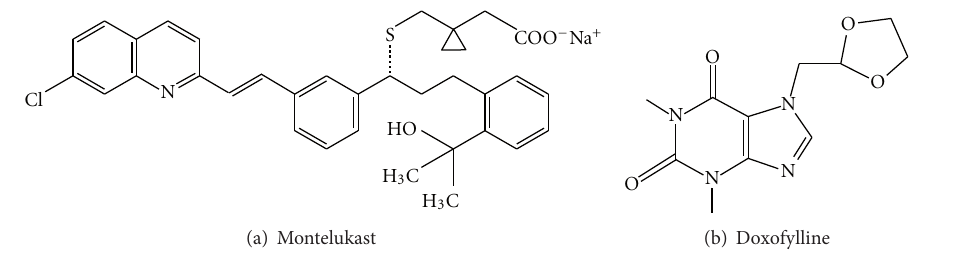
F 1: Chemical structure of the drugs.